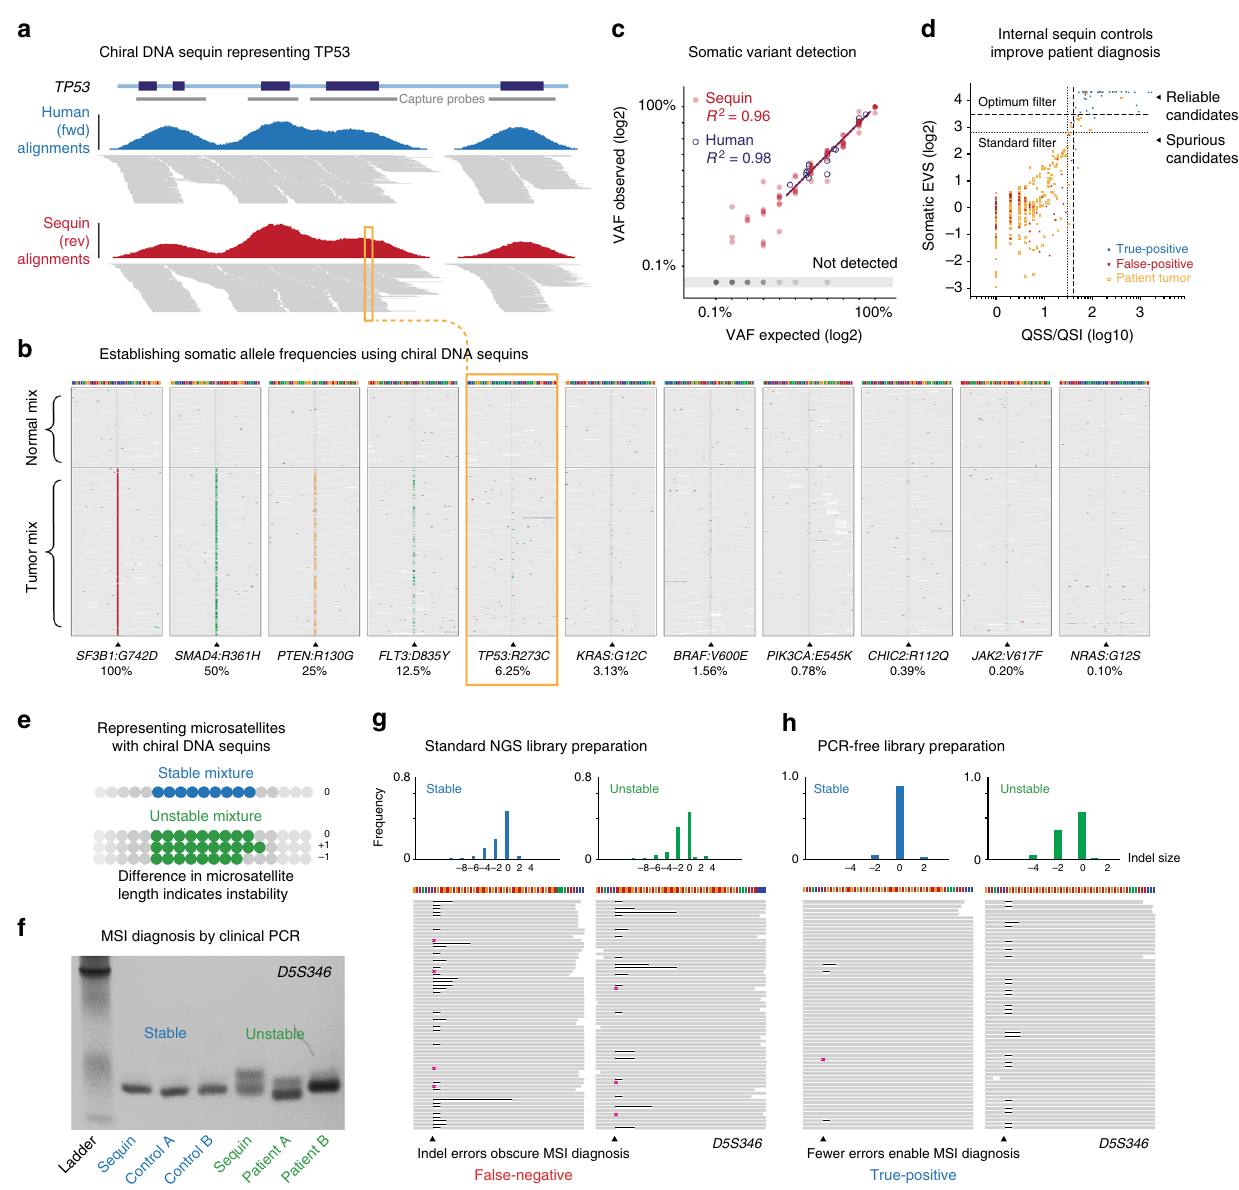
Fig. 6 Representing cancer mutations and microsatellites with chiral DNA sequins. a Genome browser view showing target-enriched sequencing alignments from patient tumor DNA (blue) and chiral sequins (red) at the TP53 locus. Gene annotation and capture probes (gray bars) are indicated above. b Sequencing alignments from chiral sequins at sites of cancer mutations synthetically represented across a range of variant allele frequencies (VAFs). Both normal (upper) and tumor (lower) mixtures are shown and mismatched bases colored. c Scatter plot shows observed vs expected VAFs for sequin variants (red) and human variants in cancer reference samples (blue). Linear regression measures detection accuracy within the VAF range 1.5 – 100%. d Scatter plot shows con fi dence scores (QSS/I and SomaticEVS) for somatic variant candidates in a single patient tumor sample and internal sequin controls. Optimized quality thresholds (dashed lines) exclude all false-positives (red), while retaining maximum true-positives (blue) and human variant candidates (orange). Conventional best-practice thresholds (dotted lines) are shown for comparison. e Schematic illustrates the design of stable (blue) and unstable (green) microsatellite sequins. f Size measurement of the microsatellite locus D5S346 via PCR and gel electrophoresis for sequins (stable and unstable mixtures), MSI patient samples ( MSH6 / MLH1 mutants), and matched controls. Size shifts between stable/unstable sequin microsatellites and between patient/control DNA are indicative of MSI. g , h Comparison of NGS alignments using standard ( g ) and PCR-free ( h ) library preparation protocols. (Lower panel) Alignments are shown for stable (left) and unstable (right) sequin mixtures at the microsatellite locus D5S346 , with black bars and pink markers indicating the presence of deletions and insertions in sequencing reads. (Upper panel) Histograms show the relative frequency of insertions